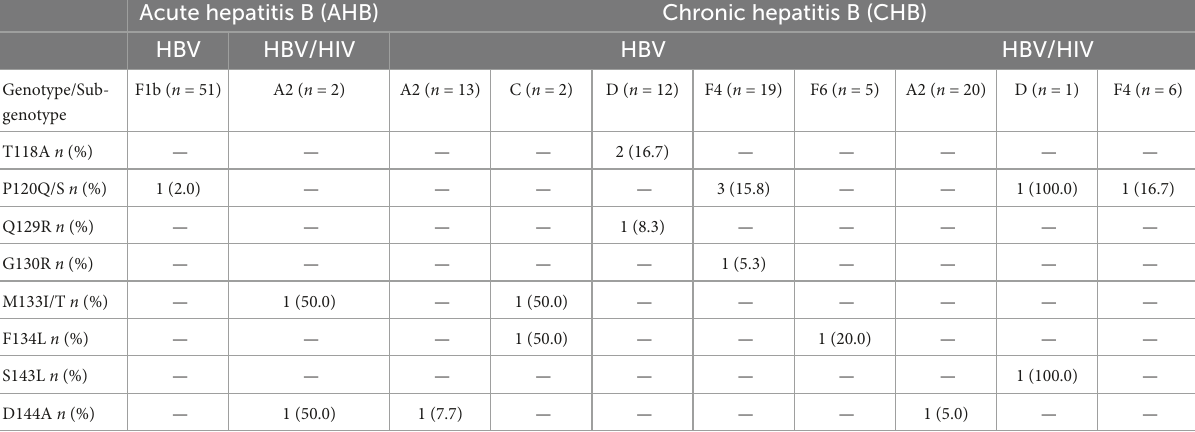
TABLE 3 Frequency of mutations in the open reading frame (ORF)-S region in patients with acute and chronic hepatitis B virus (HBV) mono and co-infection according to the infecting genotype. Acute hepatitis B